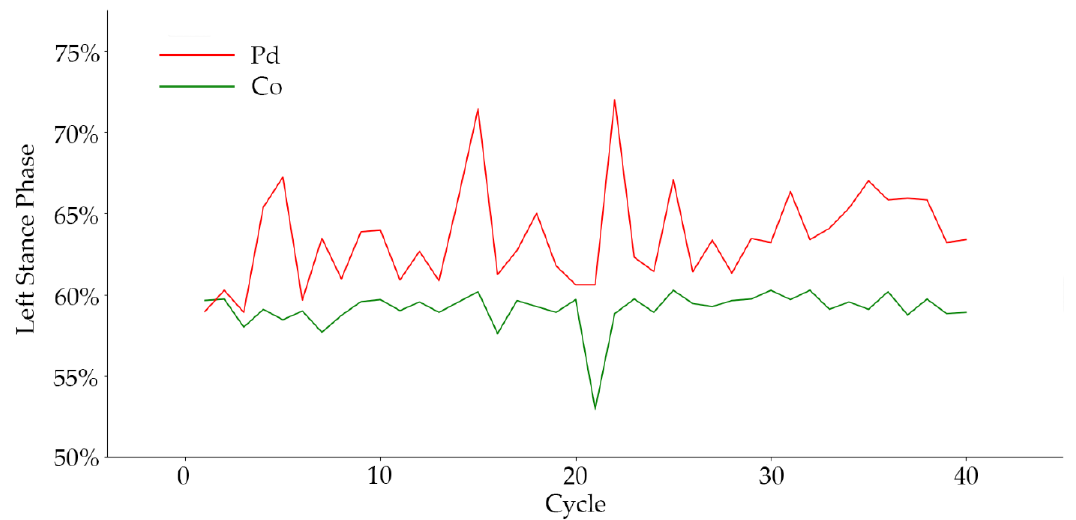
Figure 9. The proportion of left foot support between control subjects and PD patients (one subject in each